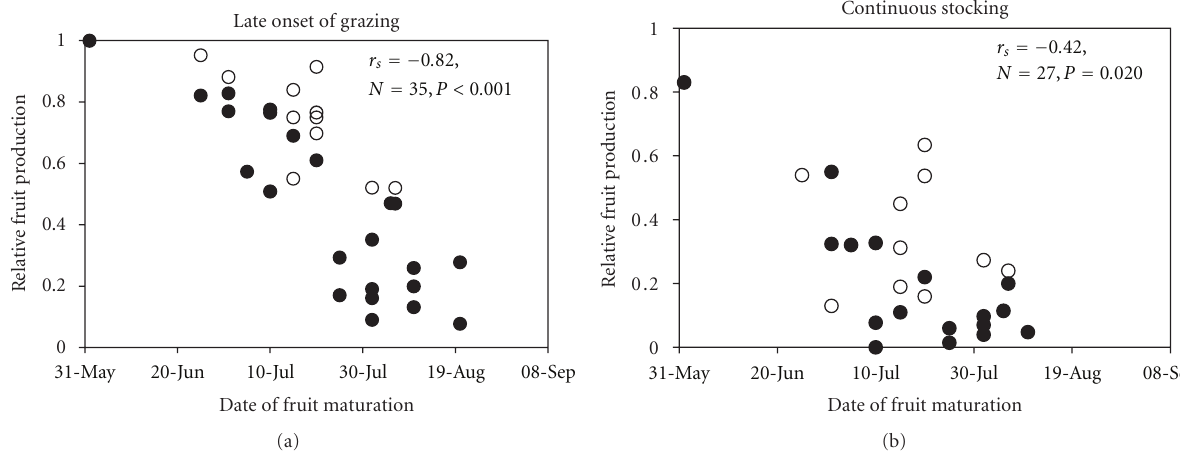
Figure 3: Mean per-species relative fruit production (proportion of inflorescences developing to mature fruit stage) of grasses (open circles) and herbs/sedges (filled circles), as a function of each species’ date of fruit maturation (see text for explanation). Two grazing regimes were compared, late onset of grazing (grazing from mid-July to early October), and continuous stocking (grazing from mid-May to early October) in a semi-natural grassland at Harpsund, see text for explanations. Spearman’s rank correlation coe ffi cients, r s , are shown, together with significance tests. For clarity, no error bars are shown.